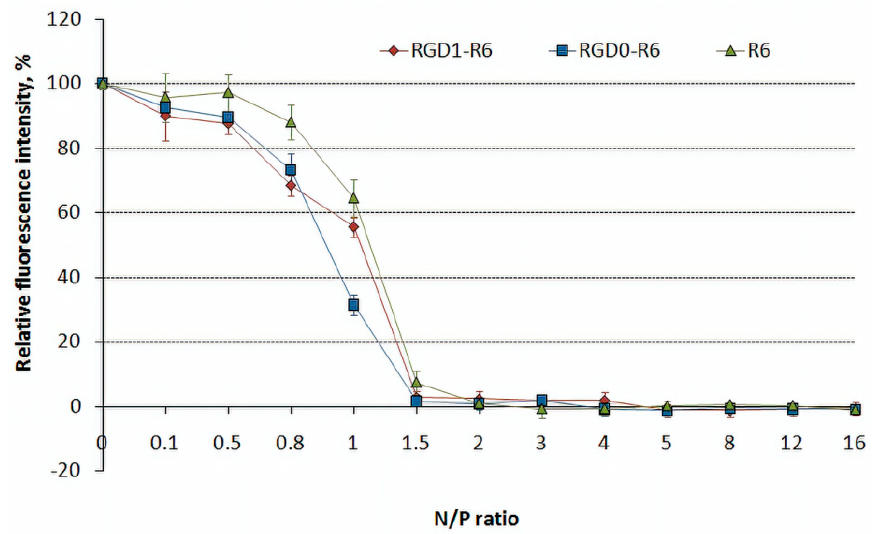
Figure 1. EtBr exclusion assay of DNA complexes with RGD1-R6, RGD0-R6 and R6 carriers. Values are the mean ± SD of the mean of triplicates.